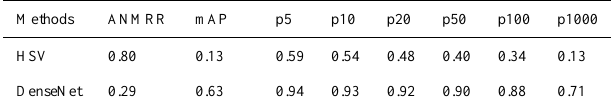
Table 2. The results of the two methods on the VGoogle-RSIR